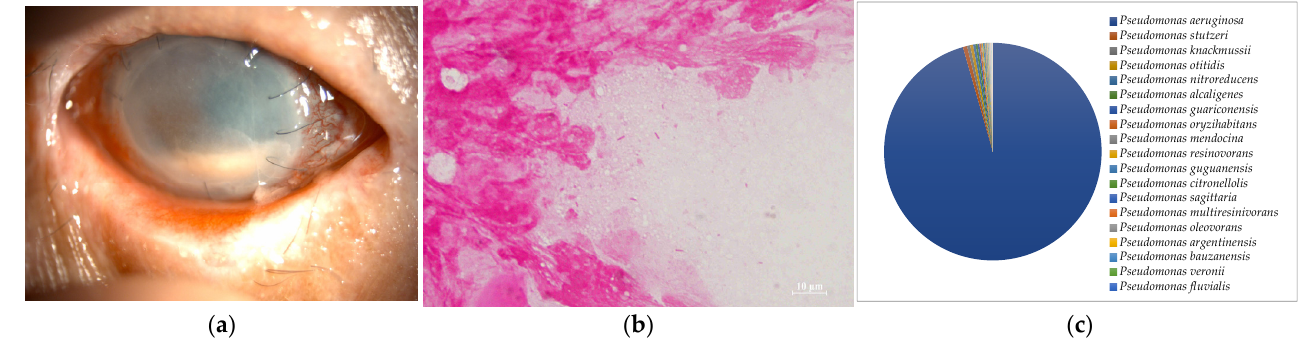
Figure 2. ( a ) Anterior segment photograph. A paracentral corneal abscess is present. ( b ) Smear mi- croscopy. Several large Gram-negative rods were detected. ( c ) Nanopore sequencing results (rela- tive abundance) of Case 2. Moraxella lacunata was detected as the dominant species by MinION.